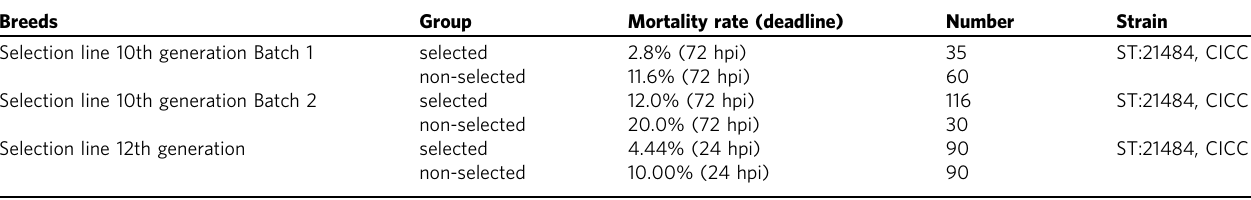
Table 1 Mortality rate of chicks by group after Salmonella typhimurium (ST) infection.